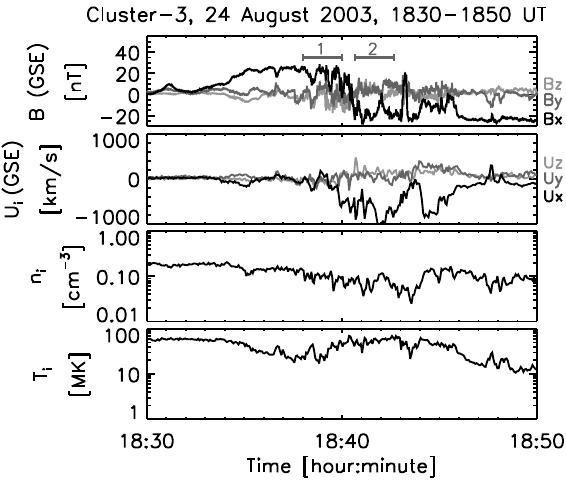
Figure 1. Time series plot of the magnetic field, the ion bulk veloc- ity, the ion number density, and the ion temperature measured by Cluster-3 spacecraft. Data are obtained by fluxgate magnetometers (Balogh et al., 2001) and electrostatic ion analyzers (Rème et al.,